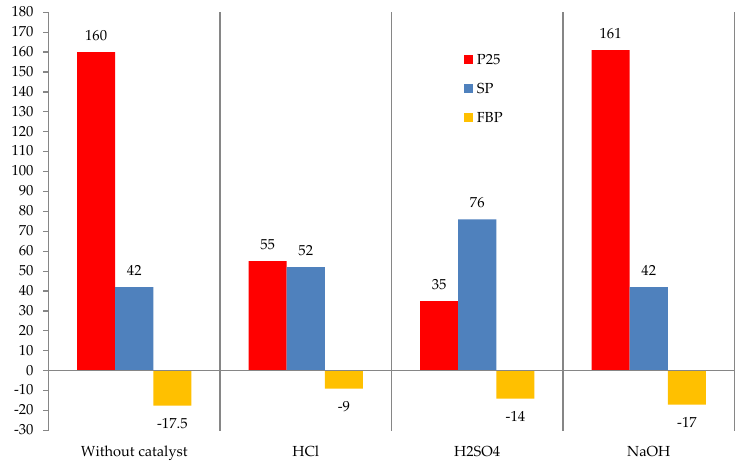
Figure 6. The effect of catalyst nature on the modification process: raw is Т1; formalin amount (including formaldehyde) 10.0 (3.7) kg/100 kg raw; catalyst amount НСl or H 2 SO 4 = 2.5, NaOH = 1.0 kg/100 kg raw; temperature 120 °C; duration 3 h. Materials 2022 , 15 , x FOR PEER REVIEW